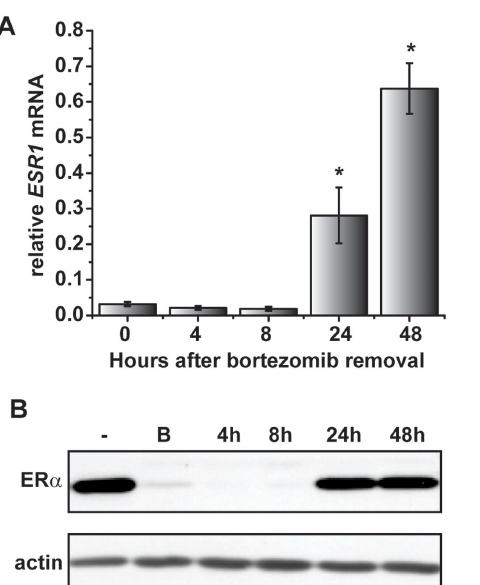
Figure 1. The effects of proteasome inhibition on ER a expression are reversible. A ) MCF7 cells were treated with bortezomib for 24 hours and harvested immediately (t=0) or at the indicated time from 4 to 48 hours post bortezomib removal. ESR1 mRNA levels were measured by qRT-PCR. Data are shown relative to an untreated control before bortezomib-treatment, which was set at 1. Results are representative of three independent experiments and are shown as mean 6 SEM. For statistical analysis, ANOVA was performed using the D Ct values followed by a post hoc Tukey’s test to compare each point to the 0 hour. Statistically significant values (p , 0.05) are indicated with an *. B ) Western blots were performed on whole cell lysates from cells that were treated with vehicle ( 2 ) or bortezomib (B) for 24 hours (24 h). After 24 hours, bortezomib was removed by washing cells twice with PBS and replacing media. Cells were then harvested at the indicated times between 4 and 48 hours after bortezomib removal. Blots were probed with antibodies for ER a , with